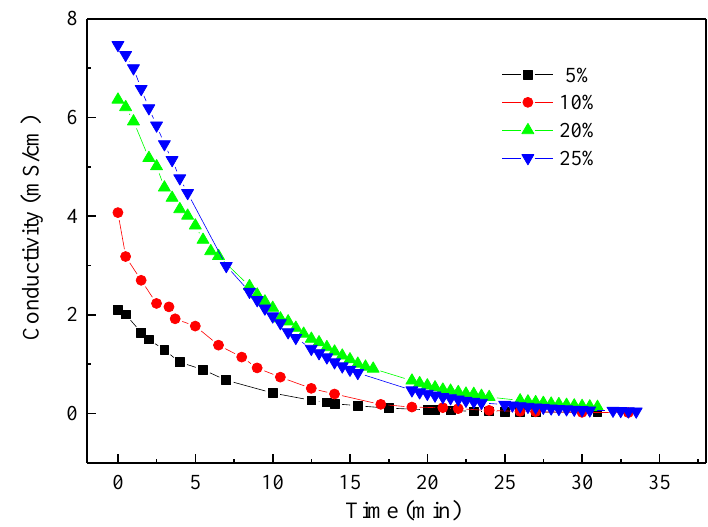
Figure 5. E ff ect of feed MSM concentration on the conductivity of the diluate chamber. The NaNO 3 concentrations were 0.17%, 0.35%, 0.70%, and 0.83%, respectively, when the MSM concentrations were 5%, 10%, 20%, and 25%.